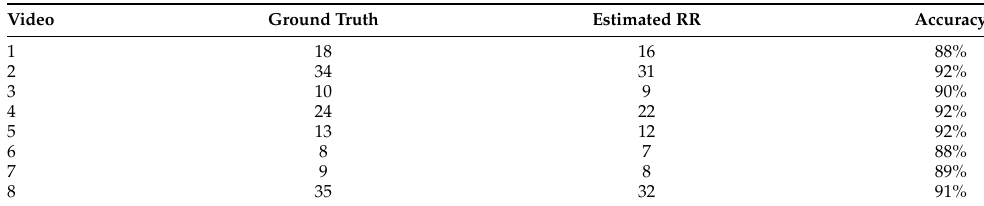
Table 3. The detailed results of the breathing.